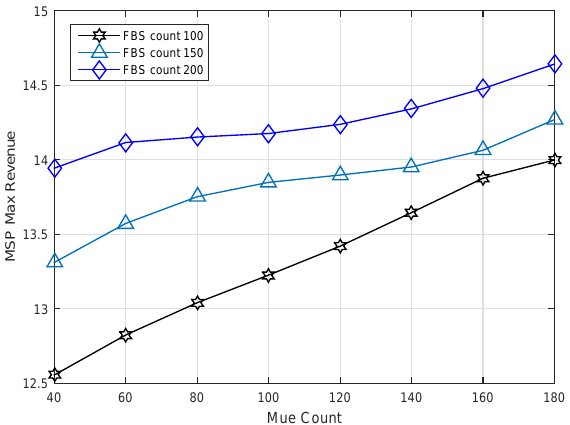
Figure 9. MSP max revenue versus MUE count under different FBS counts.